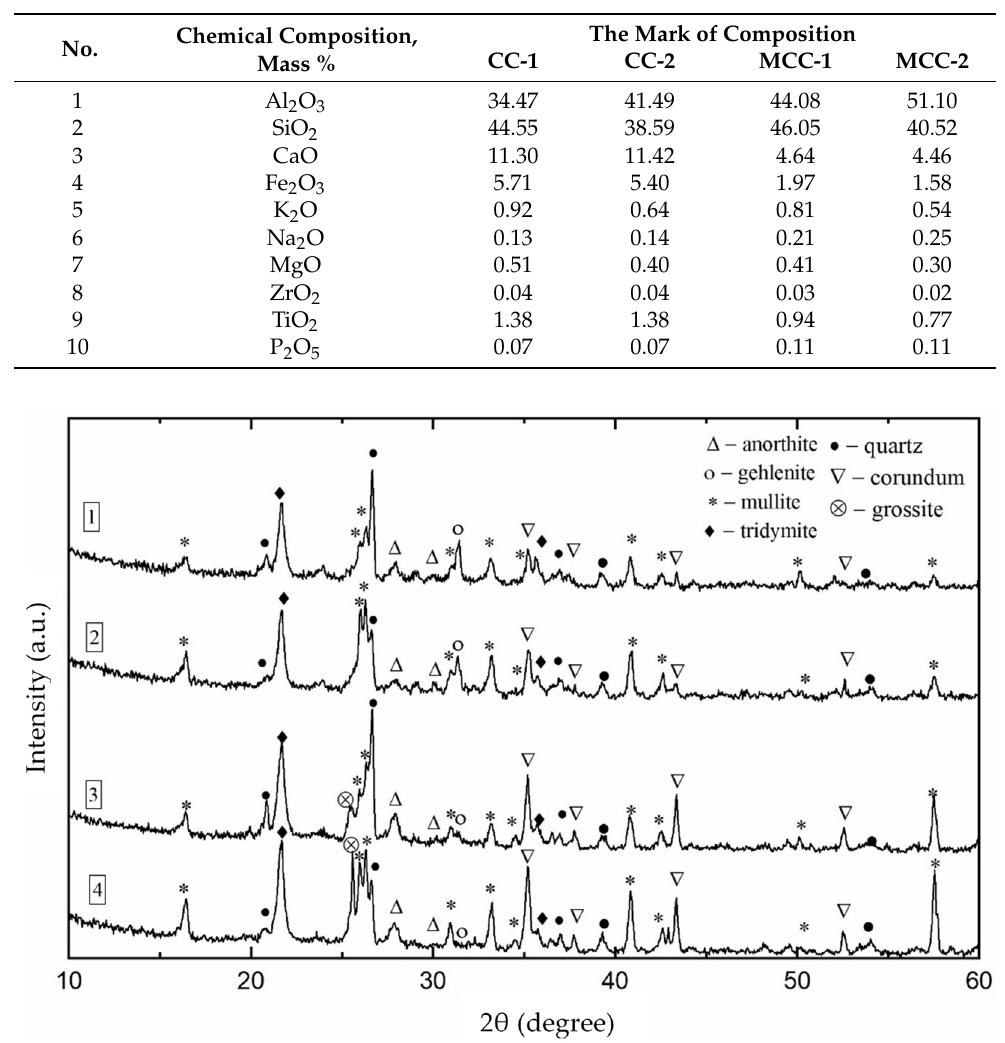
Figure 3. X-ray diffraction patterns of castables after thermal treatment at the temperature of 1100 °C: 1—CC-1; 2—CC-2; 3—MCC-1; 4—MCC-2.